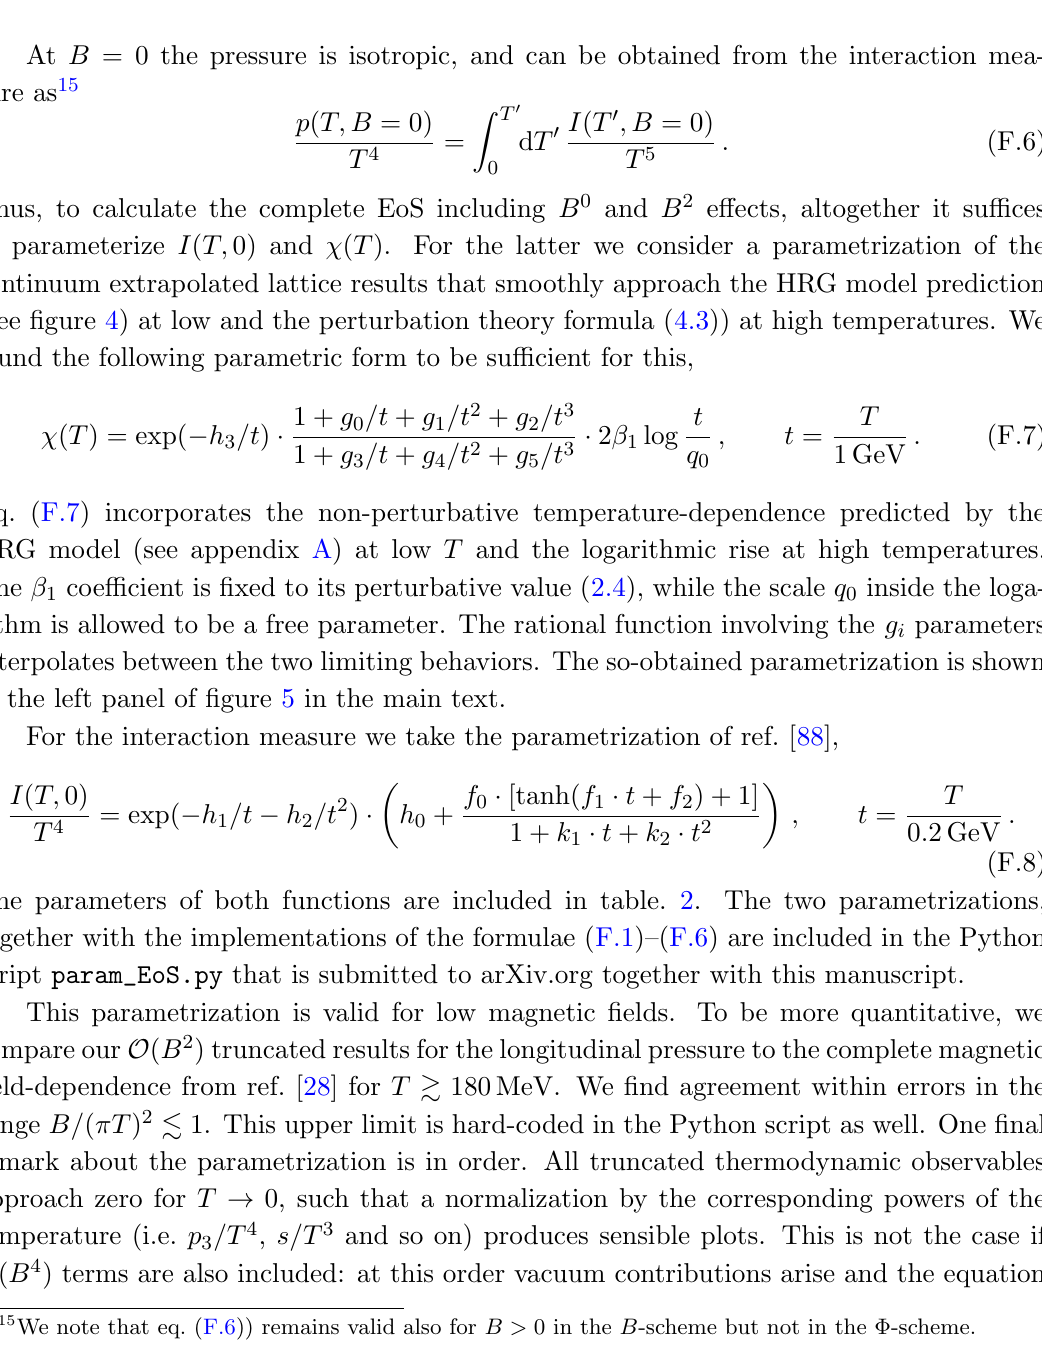
Table 2 . Parameters of the functions (F.7) and